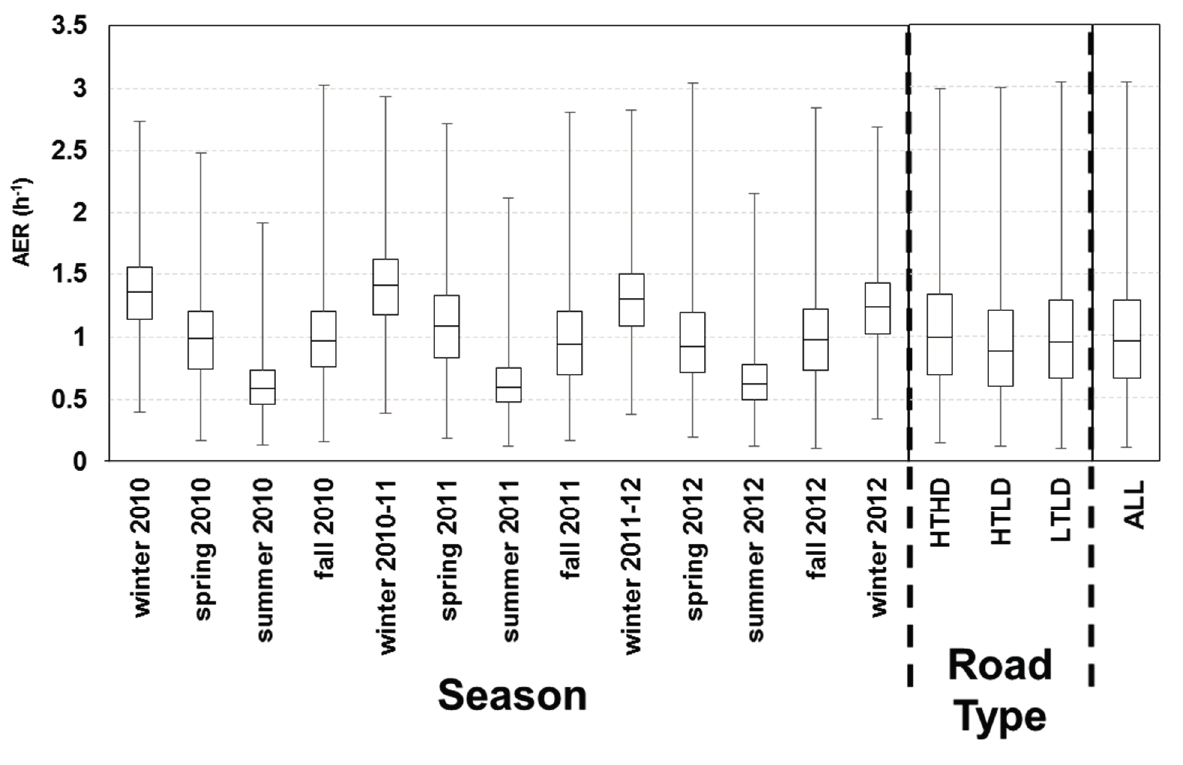
Figure 5. AER predictions for 213 homes across three years of health study with results for each season and road type. Boxes correspond to median, 25th and 75th percentiles; and whiskers correspond to minimum and maximum values. Winter includes December, January, and February; spring includes March, April, May; summer includes June, July, August; fall includes September, October, and November.